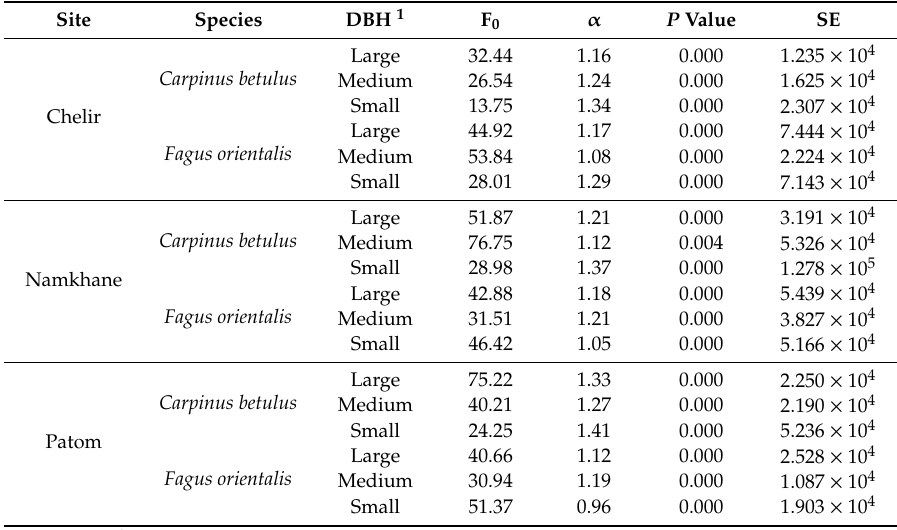
Figure 4. Tensile force at failure point versus root diameter for Carpinus betulus (blue circles) and Fagus orientalis (red circles) within three classes of diameter at breast height (DBH; small = 7.5–32.5 cm; medium = 32.6–57.5; and large = 57.6–82.5 cm) at three sites (Chelir, Namkhane, Patom). Solid ( C. betulus ) and dashed ( F. orientalis ) lines show power-law regression curves fitted to the data. Table 4. Coe ffi cients and statistical parameters of the power-law regressions for tensile force–root diameter compared by diameter at breast height (DBH)